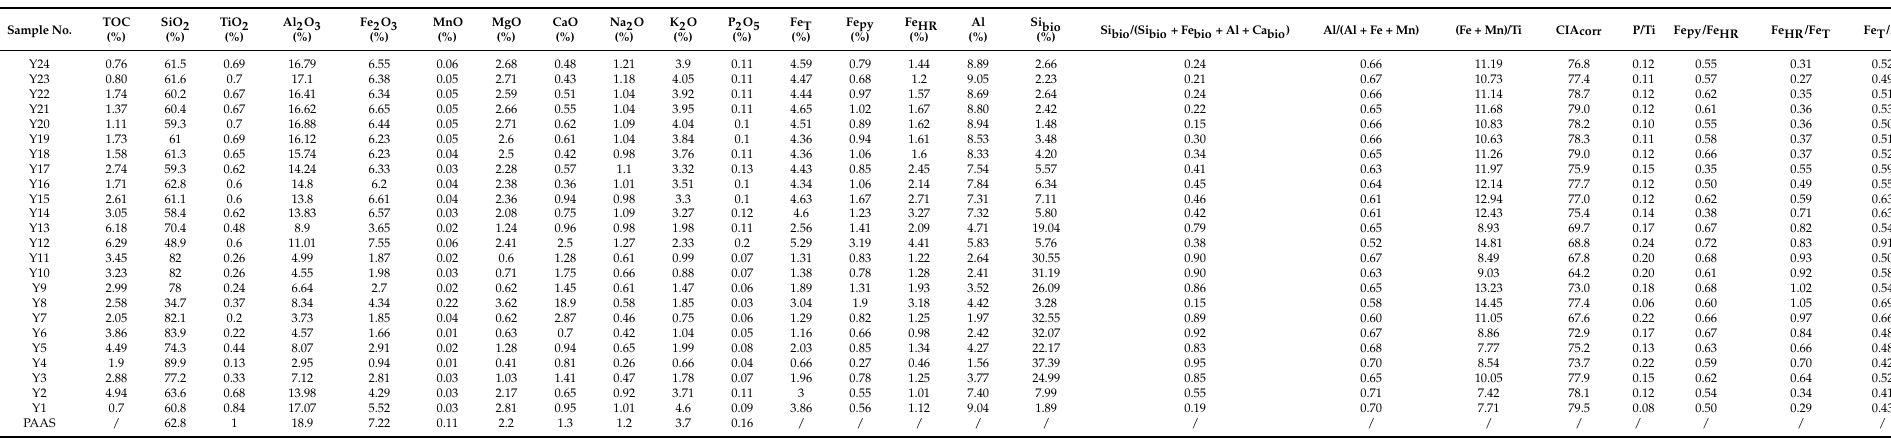
Table 1. TOC and major elements contents of the Wufeng–Longmaxi Formation in well YD1.